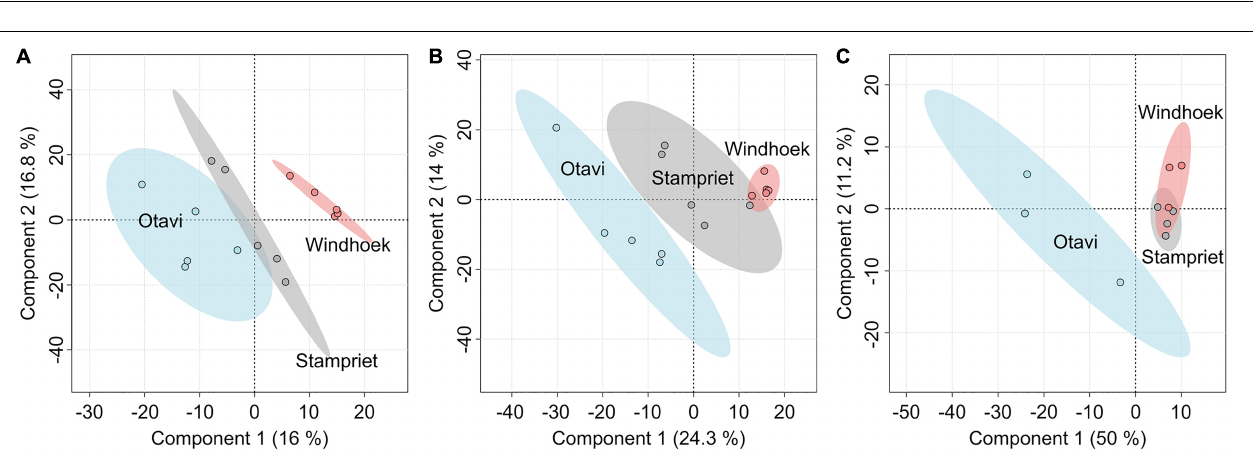
FIGURE 2 | Comparison of the nest, web, and spider volatilomes using Euler diagrams. The diagrams are based on all identified and unknown VOCs from Otavi (A) , Windhoek (B) , and Stampriet (C) . The areas are proportional to the number of VOCs.